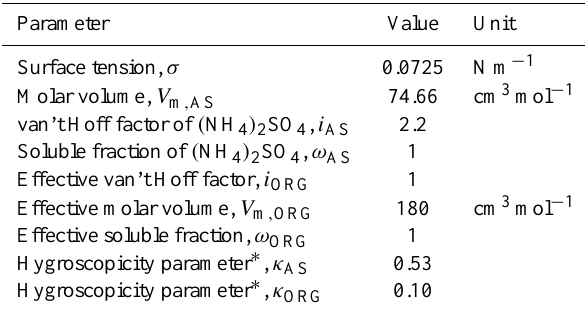
Table 2. Physical and chemical parameters describing the CCN activation curves shown in Fig. 3 for a thermodenuder setting of 25 ◦ C. The parameters are invariant at 25 ◦ C for the investigated range of C 5 H 8 :NO x values.